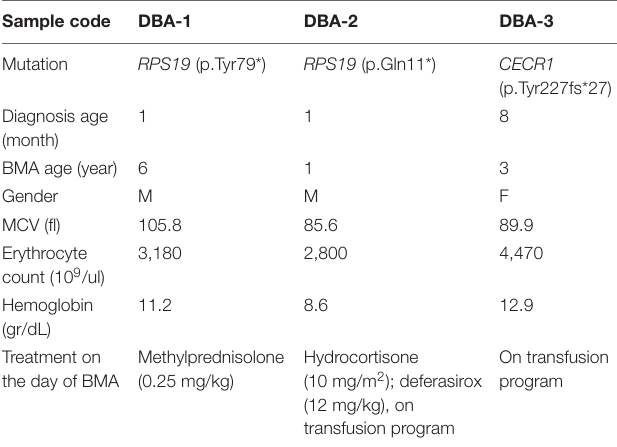
TABLE 1 | Clinical information of DBA